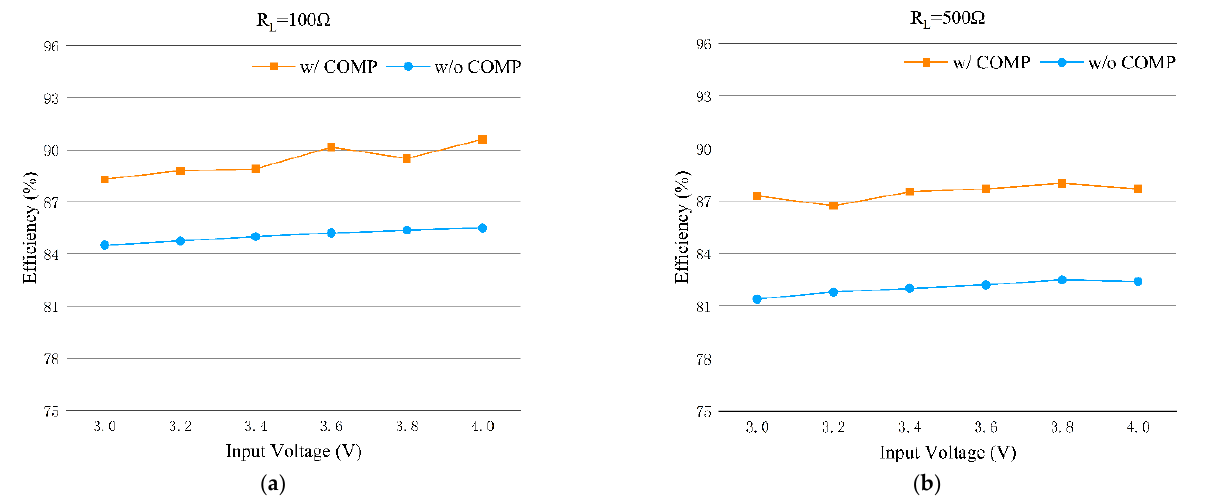
Figure 15. The power efficiency of the proposed rectifier and the rectifier without compensation method with ( a ) 100 Ω and ( b ) 500 Ω load resistance.